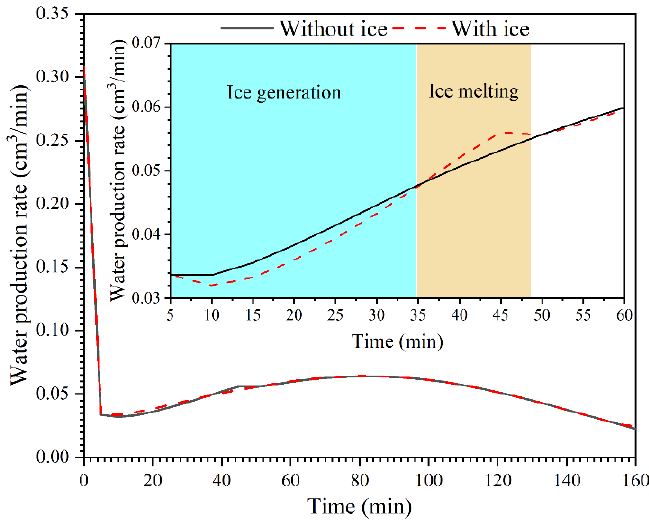
Figure 10. Water production rate with or without